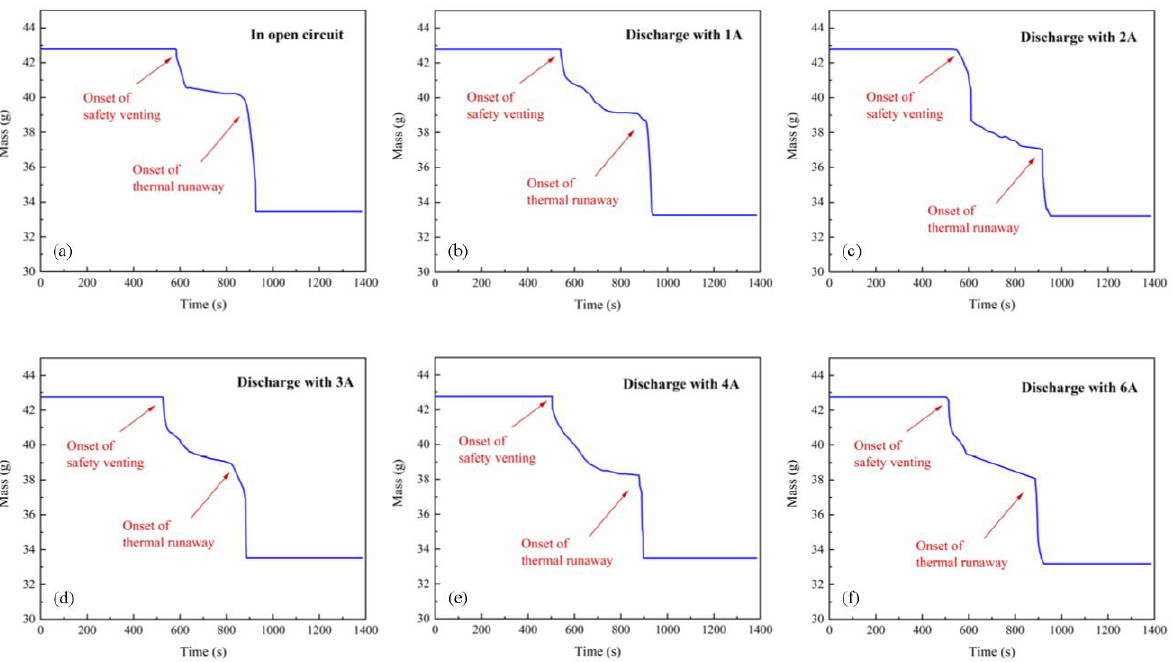
Figure 11. Representative LIB mass histories used in the calculation of discharge energetics. ( a ) The LIB in open circuit; ( b ) The LIB discharge with 1 A; ( c ) The LIB discharge with 2 A; ( d ) The LIB discharge with 3 A; ( e ) The LIB discharge with 4 A; ( f ) The LIB discharge with 1 A.